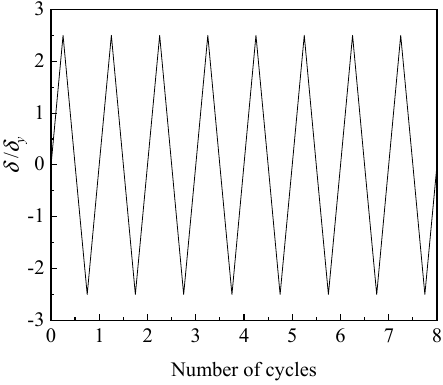
Figure 11. Loading pattern II.